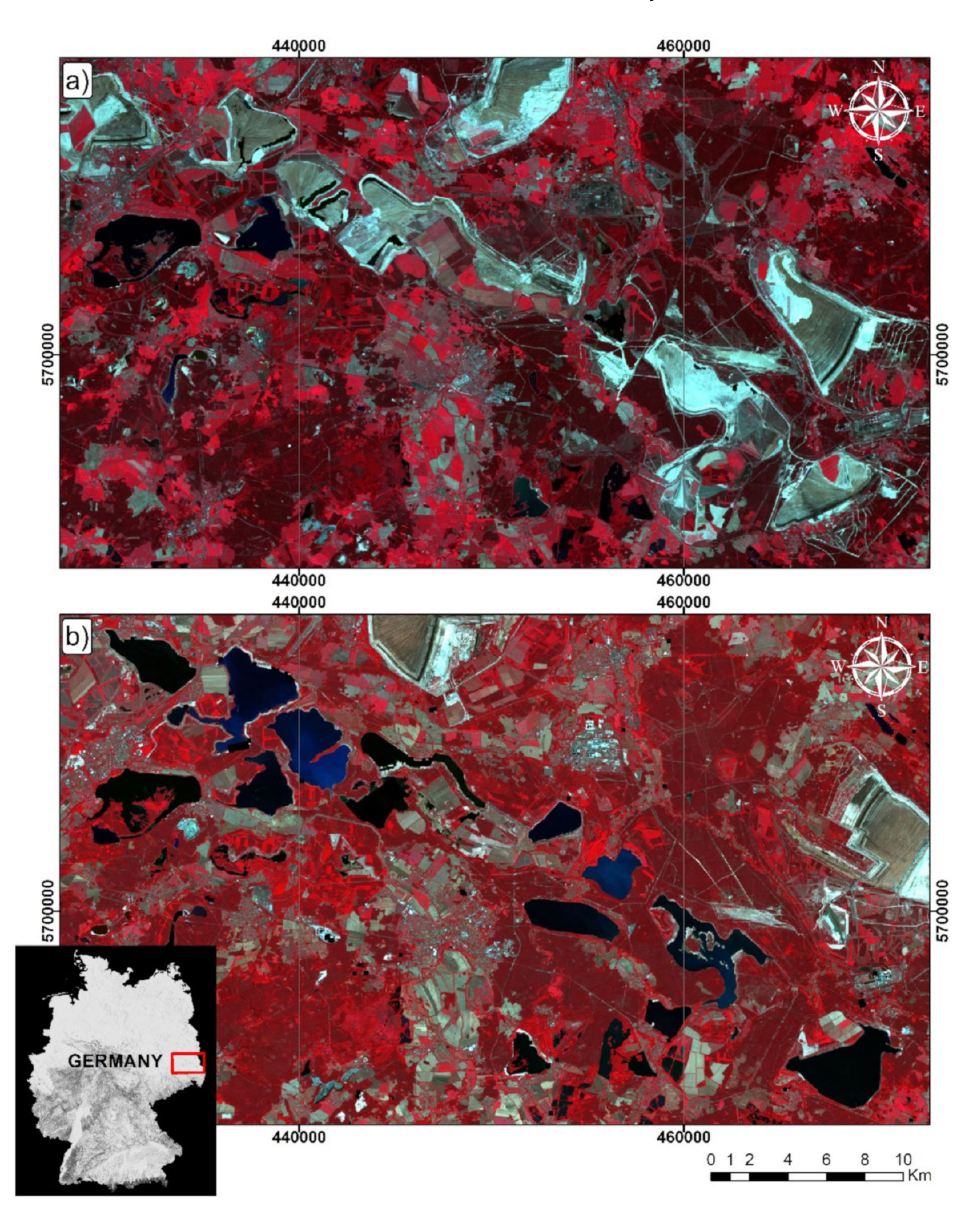
Figure 1. False-color images over the Lusatia region: ( a ) on the top, acquired in June 1985 by the Thematic Mapper (TM) on Landsat 5 (bands 4-3-2); ( b ) on the bottom, acquired in August 2020 by the Operational Land Imager (OLI) on Landsat 8 (bands 5-4-3). The false-color images were created using the Google Earth Engine